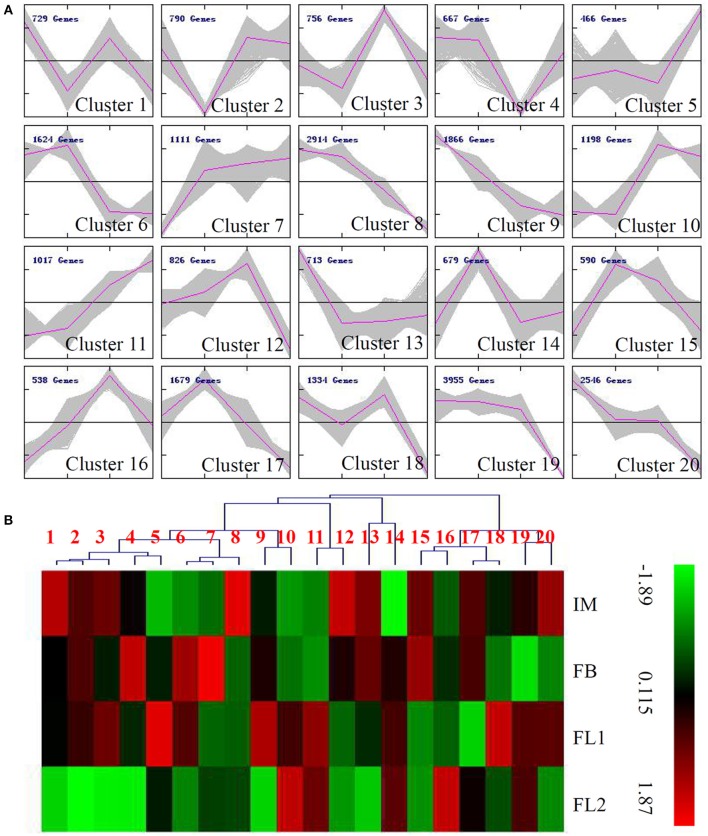
Expression profiles of the differentially expressed unigenes during the flowering process in sugar apple. (A) MeV cluster analysis of differentially expressed unigenes from the expression profiles during the flowering process. Red lines indicated the average expression level of unigenes grouped into the same Cluster under different flowering stages. (B) Heat map for cluster analysis of the differentially expressed unigenes by K-means method. Red indicates up-regulated genes and blue indicates down-regulated genes.